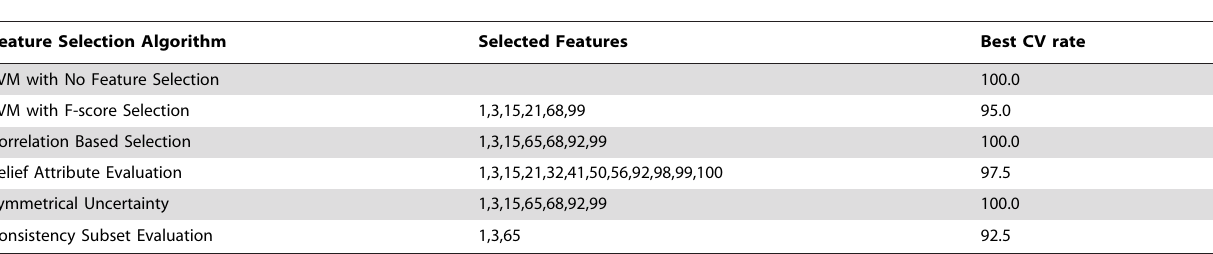
Table 7. Control vs ROCK-inhibitor-treated comparison of epithelial tissues.